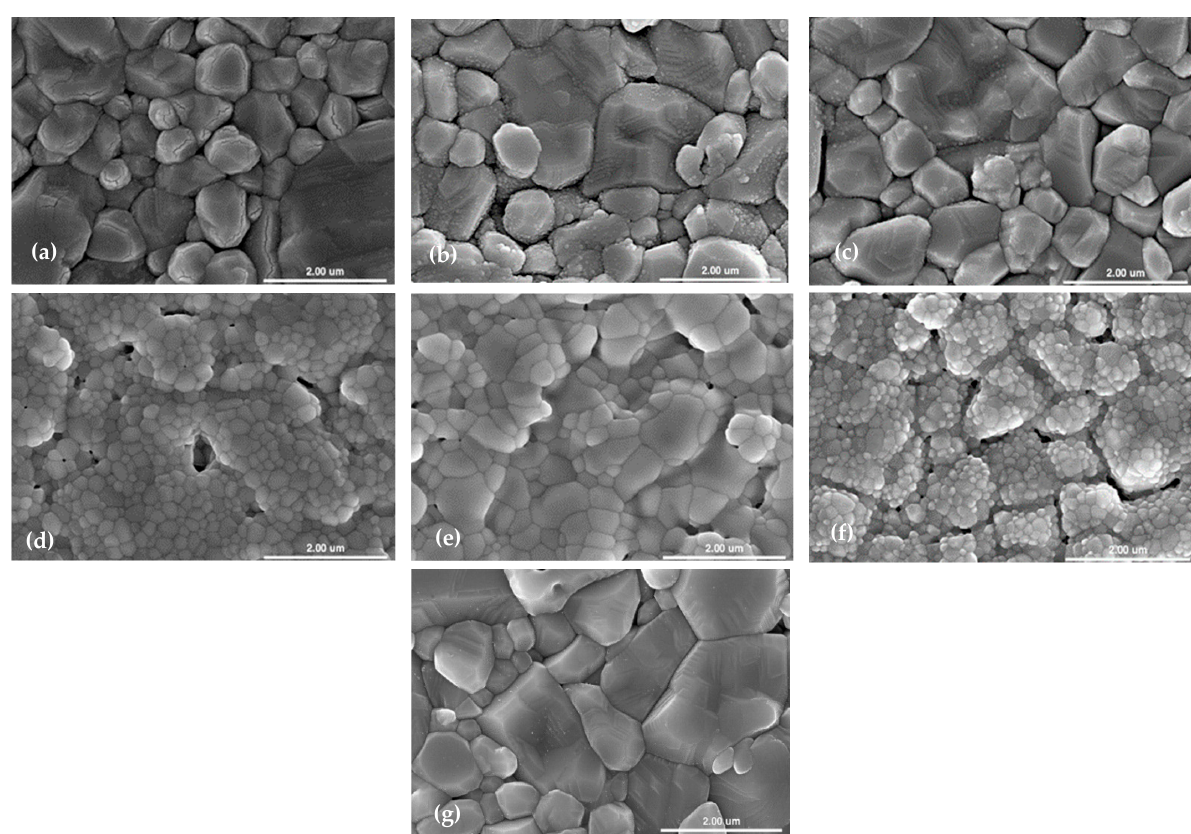
Figure 4. SEM images of the sputtered YSZ films after the thermal annealing process at 600 (above) and 1200 °C (below): ( a , d ) DC-metallic; ( b , e ) DC-reactive; and ( c , f ) RF-oxide. In ( g ) the pristine Al 2 O 3 polycrystalline substrate is shown for comparison.